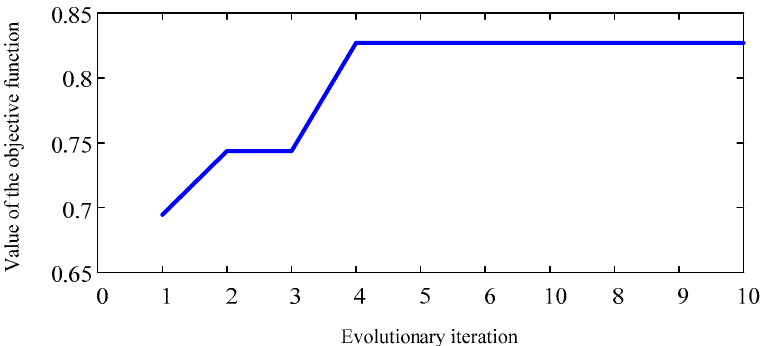
Figure 13. Envelope spectrum of optimal component by using VMD.